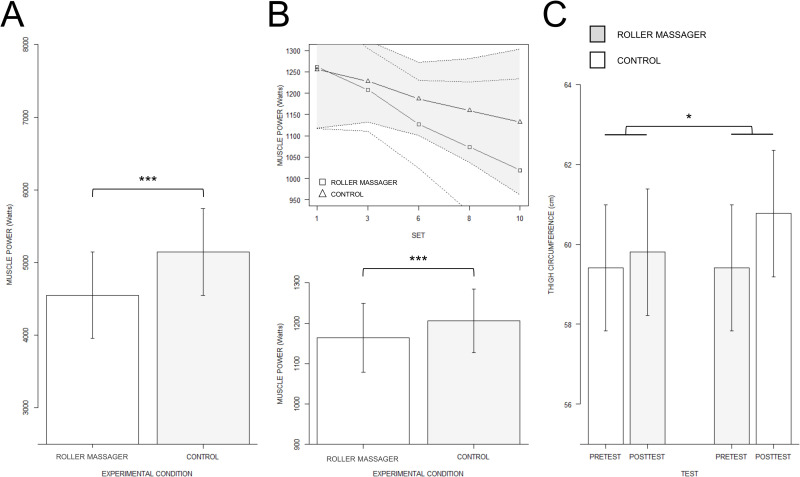
Mean muscle power and thigh circumference.A. Barplot depicting fitted estimates for the main effect of EXPERIMENTAL CONDITION on concentric power. B. Regression slopes depicting the SET by CONDITION interaction revealed by the linear mixed effects analysis carried on muscle power. C. Barplot display of the TEST by CONDITION interaction effect on thigh circumference. *** p < 0.001, *p < 0.01.